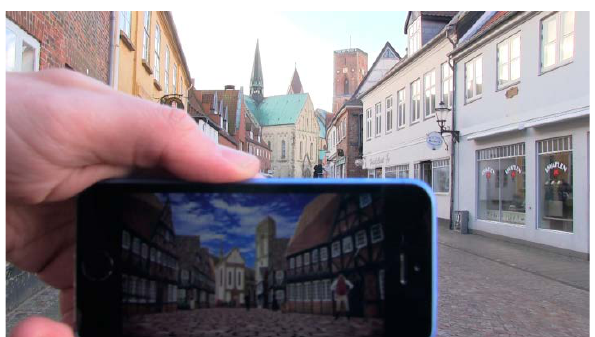
Figure 15. Mobile, mimetic representation of the past. Sydvestjyske Museer, Denmark. Photo: The